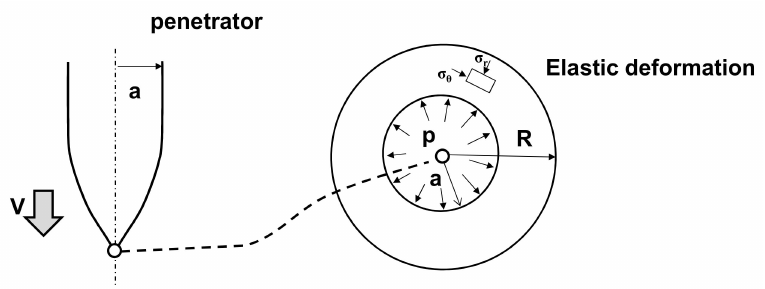
Figure 1. Expansion of the cavity pressure at the projectile tip.